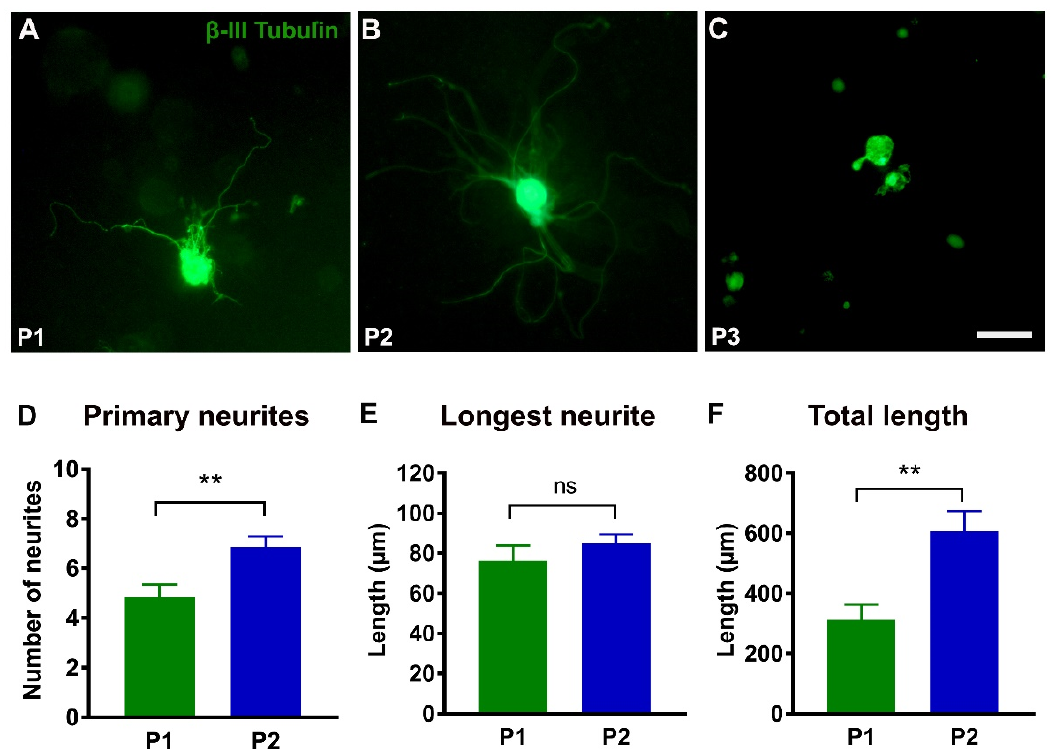
Figure 5. Neurite outgrowth from dorsal root ganglion (DRG) neurons. ( A–C ): Representative images of the DRG neurons stained for β III tubulin after 76 h in the P1, P2, and P3 hydrogels. Note that neurons in P3 hydrogel have no neurite outgrowth. ( D – F ): Histograms showing the number of primary neurites (P1, n = 26 and P2, n = 48), the length of the longest neurite (P1, n = 26 and P2, n = 48), and the total length ( n = 10) of all neurites in P1 and P2 hydrogels. Error bars show the S.E.M. p < 0.01 is indicated by **. ns, not significantly different. Scale bar, 50 µm.